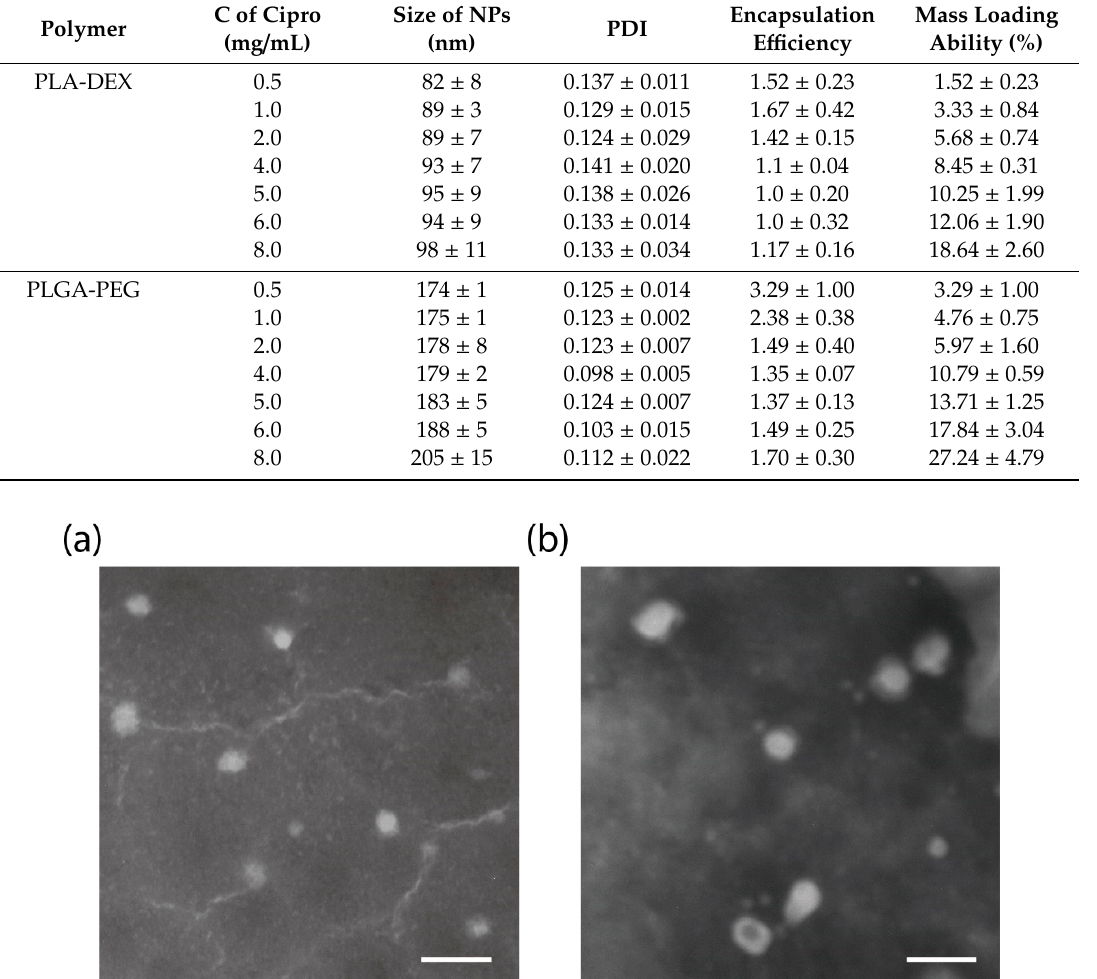
Table 1. NP parameters of effective diameter, polydispersity, and mass-loading ability for PLA-DEX and PLGA-PEG. (n = 3; mean ± S.D.). Polymer C of Cipro (mg/mL)